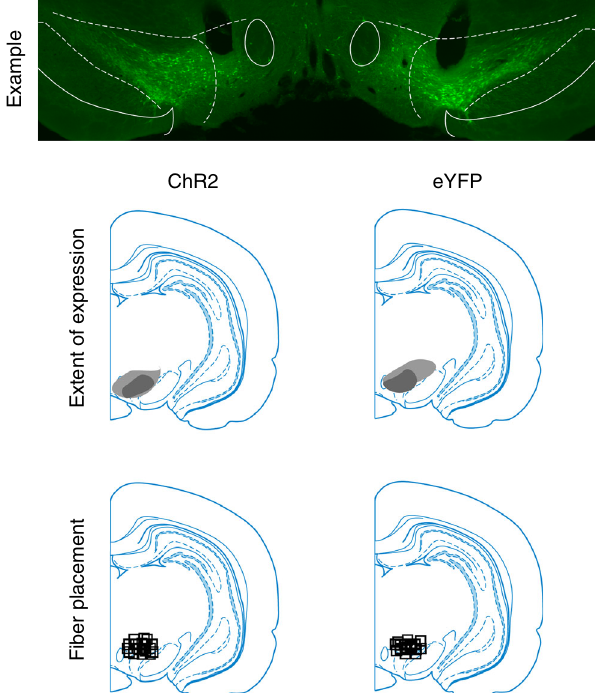
Fig. 1 Histological veri fi cation of Cre-dependent ChR2 and eYFP in TH + neurons and fi ber placement in the VTA for Experiments 1, 2, and 3. Top row: example of the extent and location of virus expression in VTA and openings in the tissue re fl ecting fi ber placement, ~5 mm posterior to bregma. Middle row: Representation of the bilateral viral expression; dark shading represents the minimal and the light shading the maximal spread of expression at the center of injection sites. Bottom row: Approximate location of fi ber tips in VTA, indicated by black